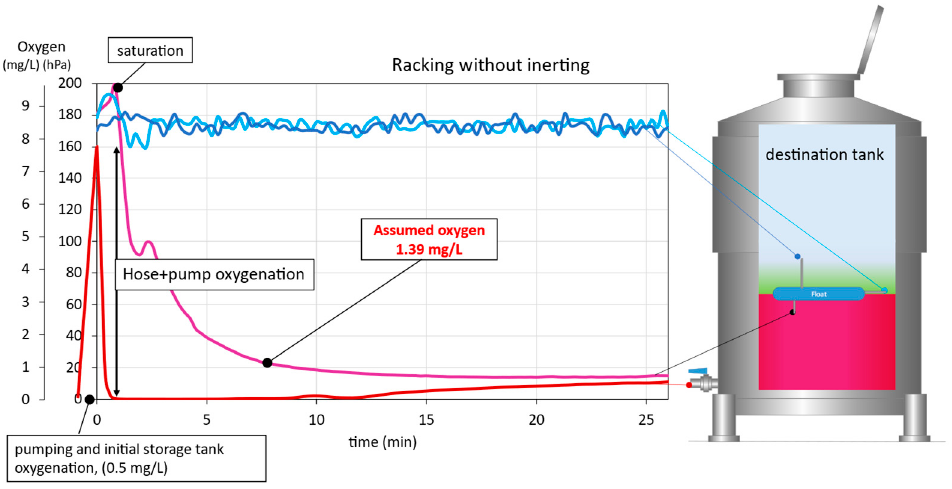
Figure 3. Wine DO evolution in the destination tank during racking without inertization.